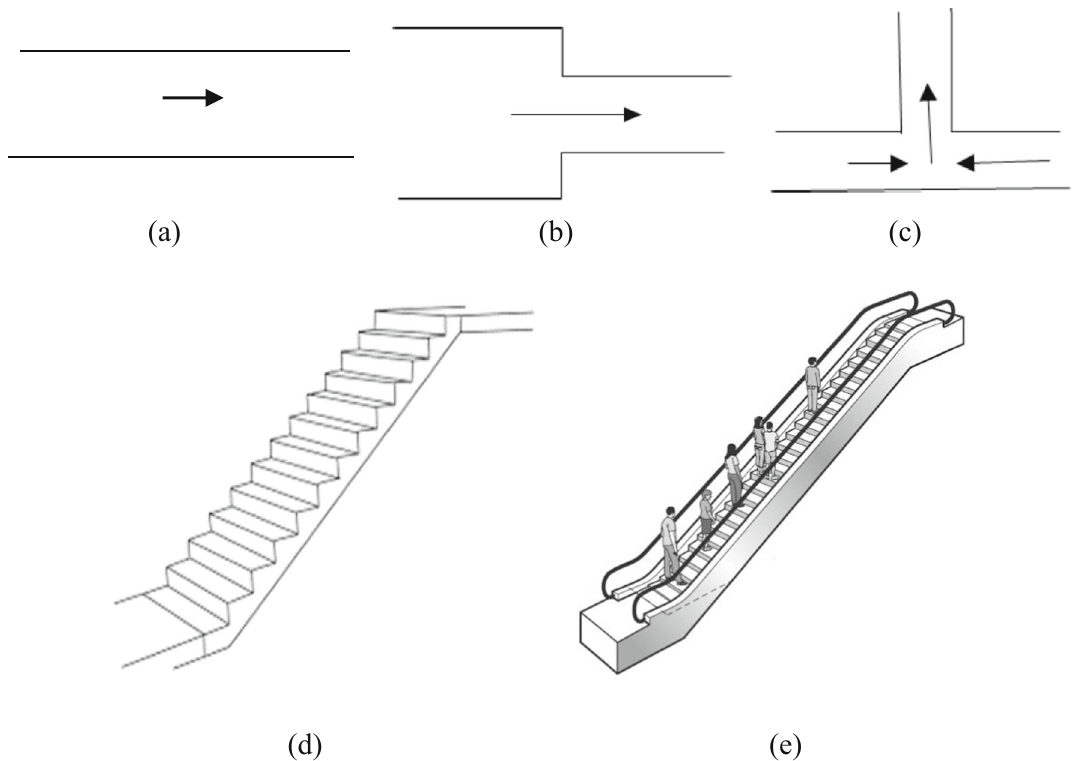
Fig. 4 Line diagrams of Geometric elements ( a ) Corridor ( b ) Bottleneck ( c ) T – Junction ( d ) Stair case ( e )